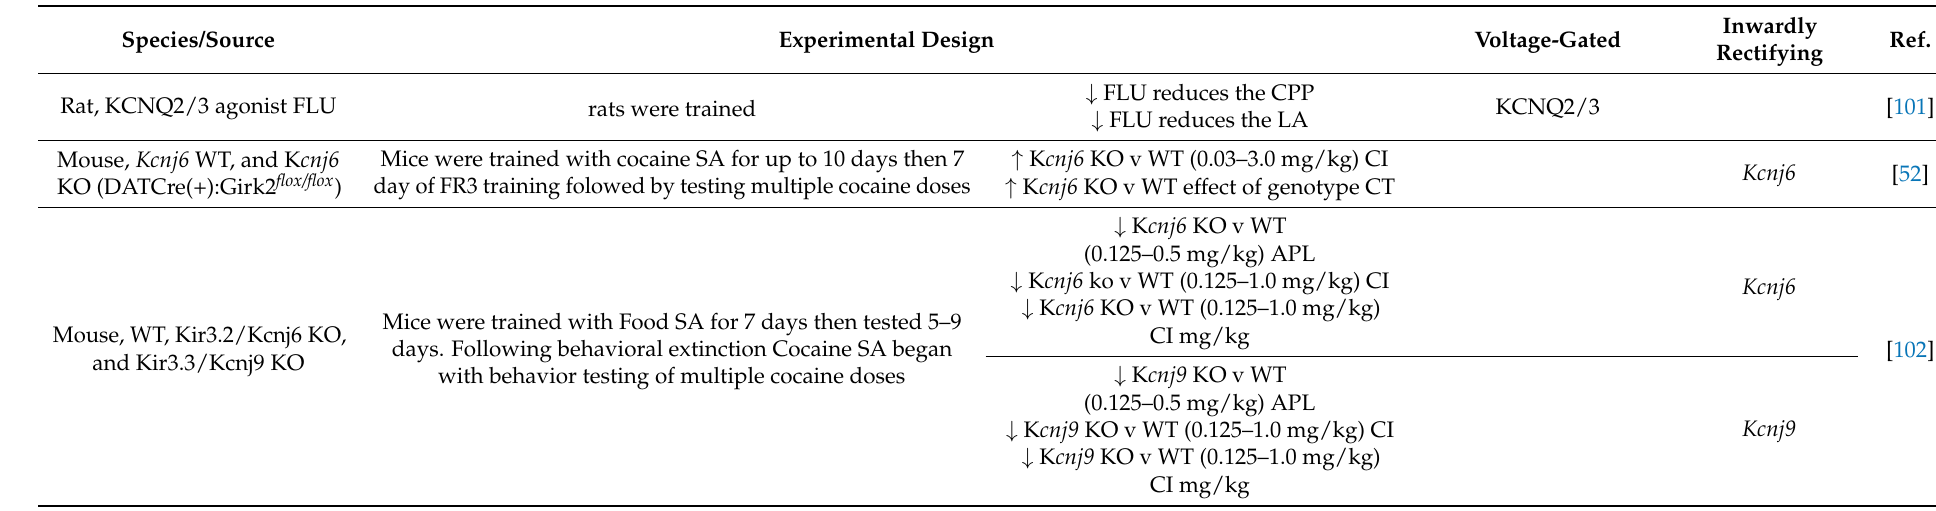
Table 3. Potassium Channels Effected by